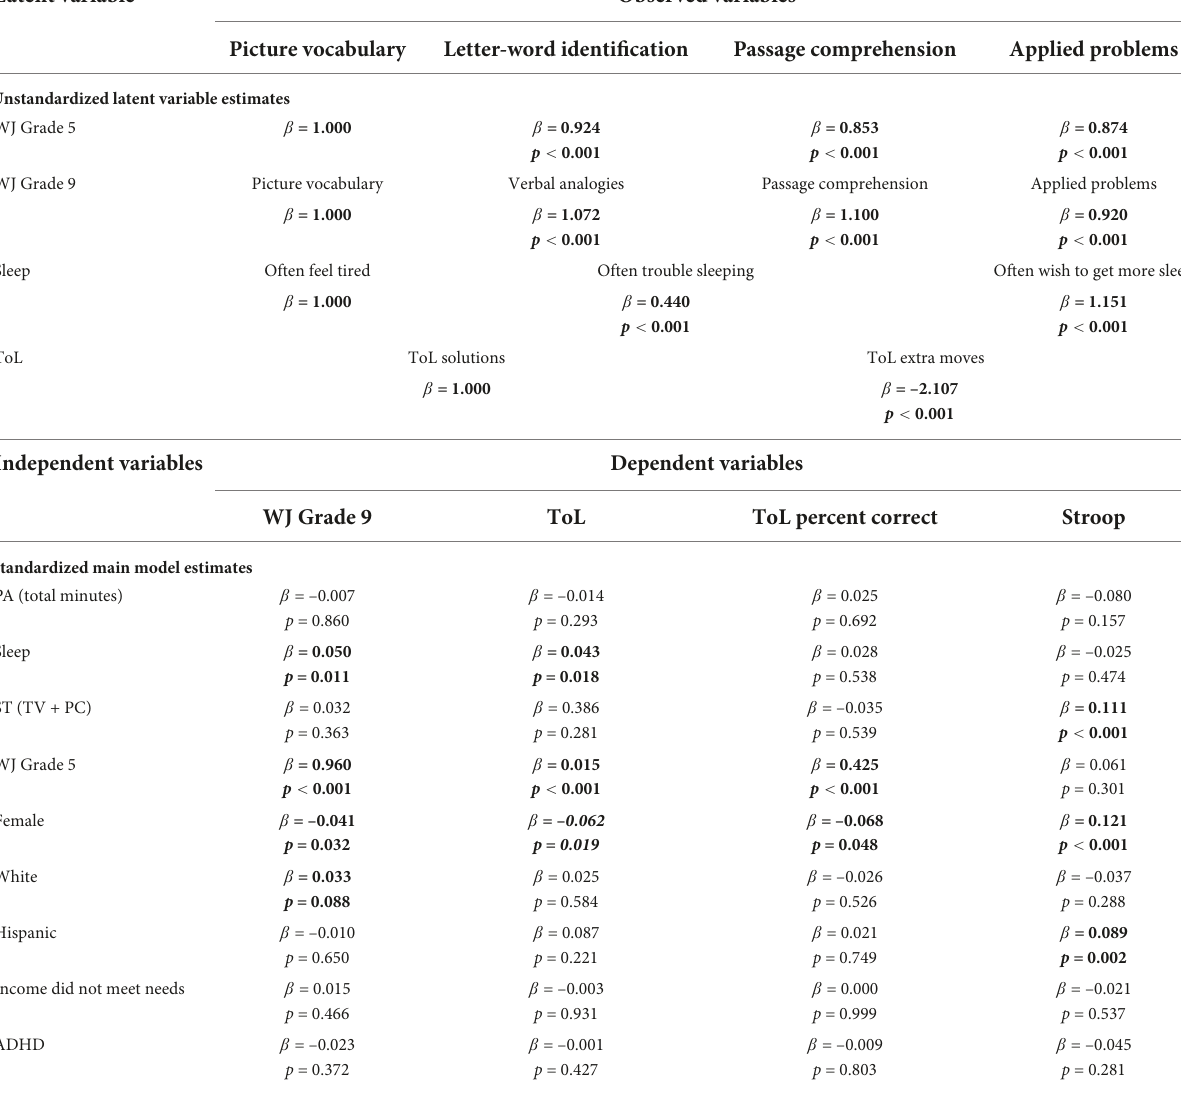
TABLE 4 Predictive effects for sensitivity